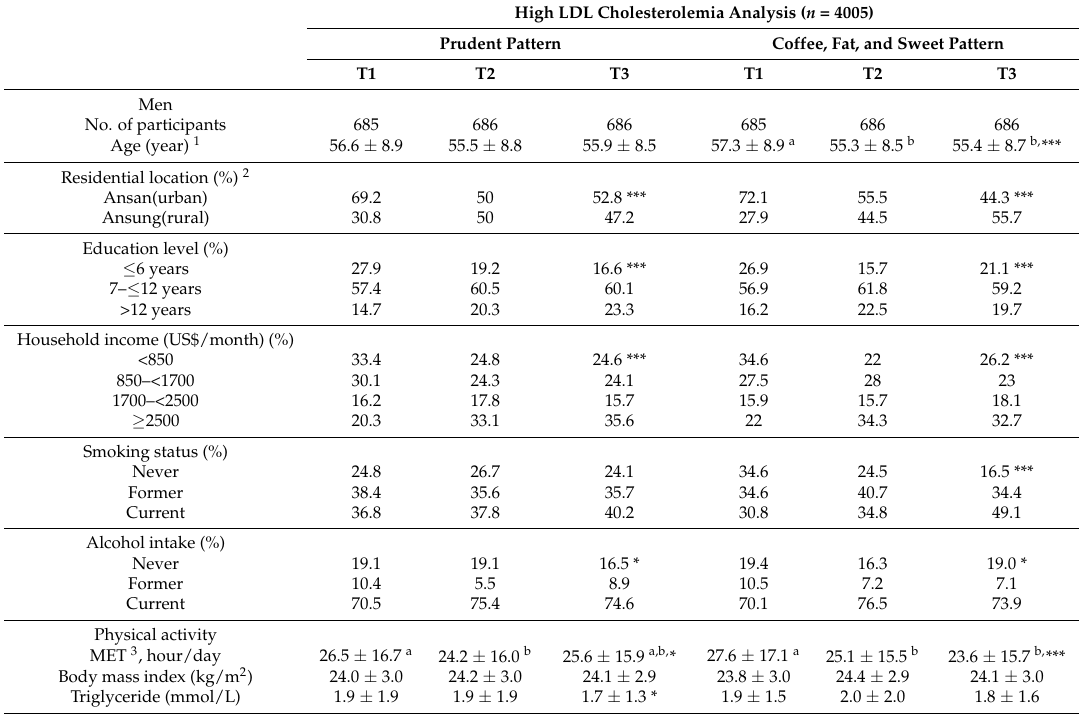
Table 3. Characteristics of Korean adults in high low-density lipoprotein (LDL) cholesterolemia analysis according to the tertile (T) categories of dietary pattern